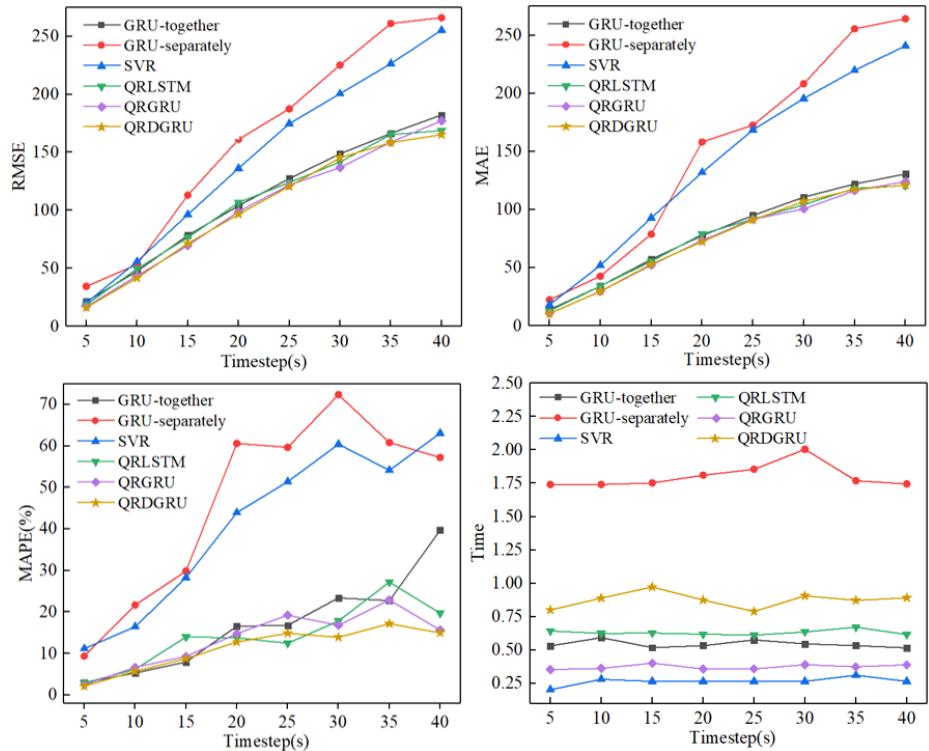
Figure 4. Performance comparison of the trajectory prediction models for drones.